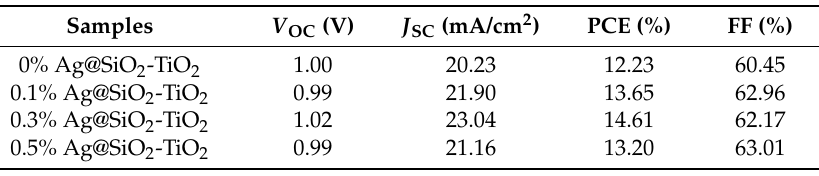
Table 2. Summarized photovoltaic parameters of PSC devices scanned form forward voltage to reverse voltage and scanned form reverse voltage to forward voltage.